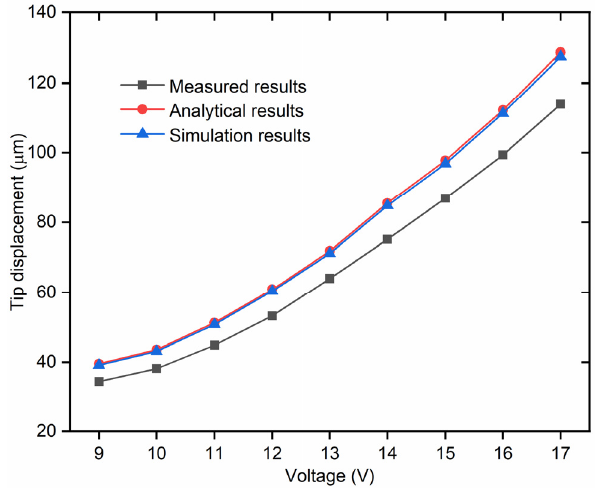
Figure 10. Measured, analytical and simulation output displacements of the actuator under the same actuation voltage.